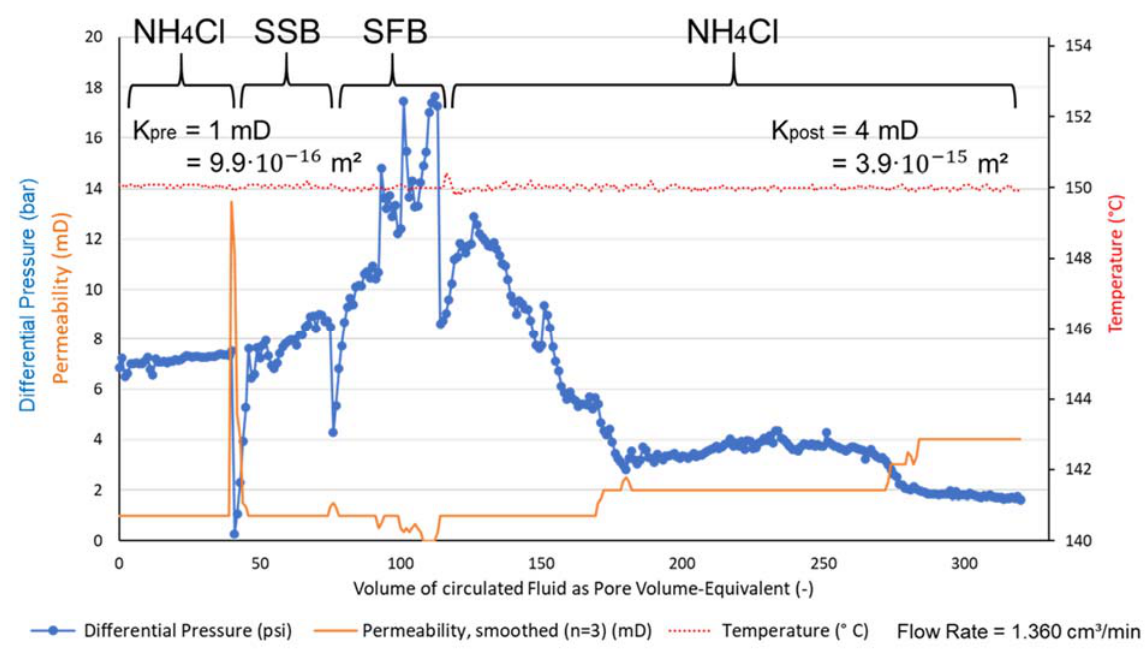
Figure 7. Pore volume—differential pressure diagram showing the development of the CFT on sample 5, applied flow rate: 1.360 mL/min; modified after [44].